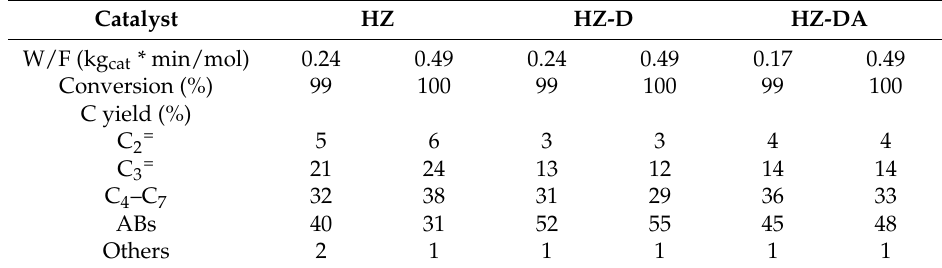
Table 3. Initial conversion and distribution of products at 400 ◦ C with different contact